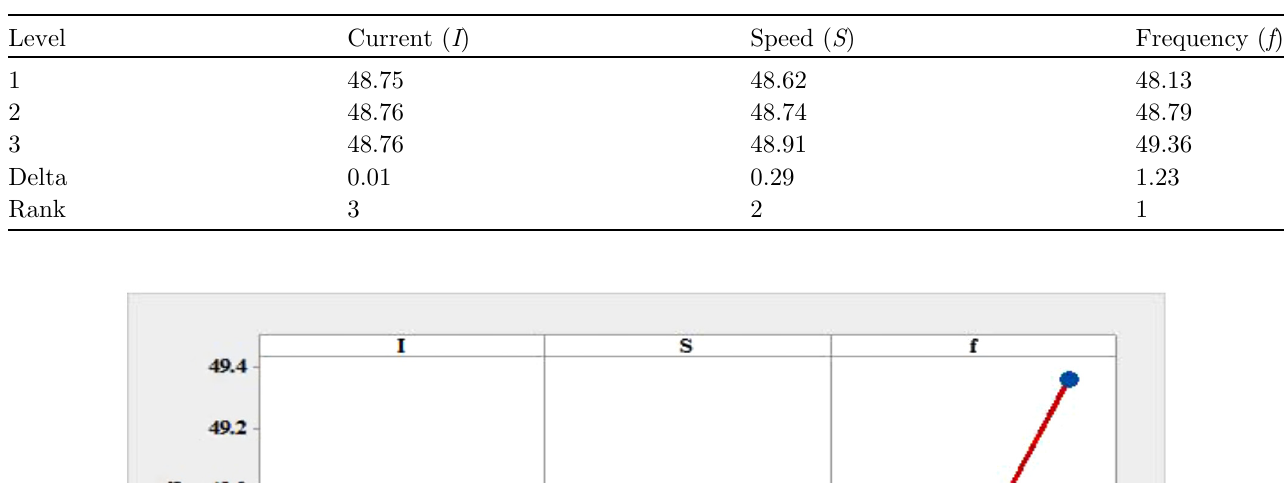
Table 5. Response table for S/N ratio of hardness of L